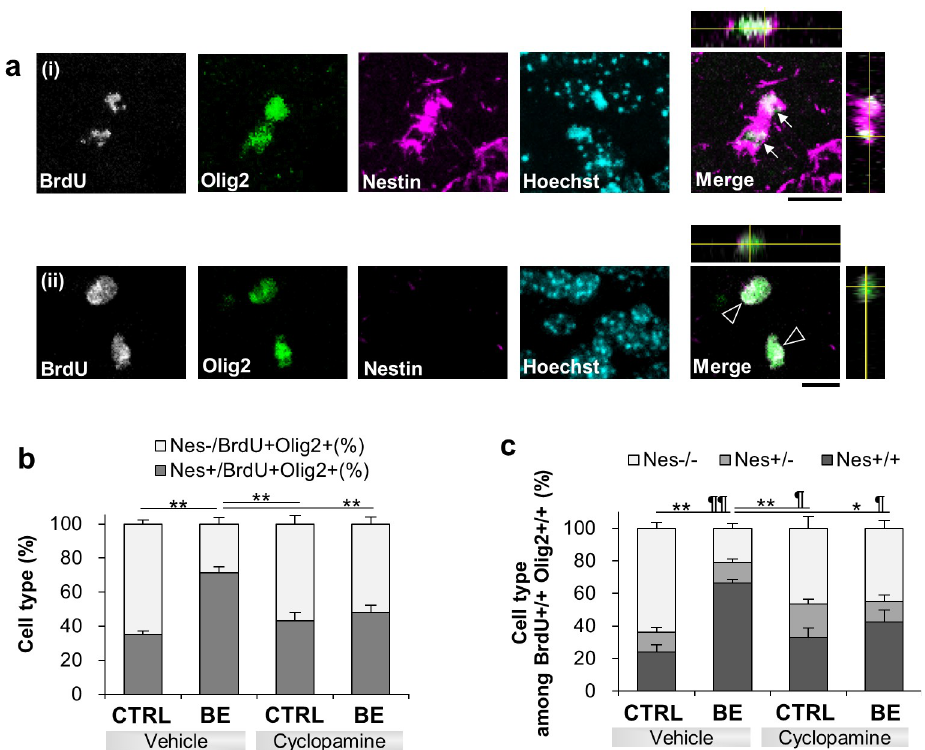
Fig 5. The role of sonic hedgehog signaling in BE-induced undifferentiation at P25. ( a ) Confocal images showing immunostaining against BrdU (gray), Olig2 (green), Nestin (Nes, magenta) along with Hoechst for vehicle-injected control mice. A merged image of the top row omitted Hoechst for clarity. The x-z and y-z cross-section views of the merged image are shown at the top and right side of the image, respectively. White arrows (a i ) and open arrowheads (a ii ) indicate BrdU+Olig2+Nestin+ and BrdU+Olig2+Nestin- cells, respectively. Scale bar, 50 μ m. ( b , c ) Percentages of Nestin labeling among BrdU+Olig2+ singlet cells ( b ) and doublet cells ( c ) for the four conditions described above. � p < 0.05; �� p < 0.01 for Nestin+ or Nestin+/+, and ¶p < 0.05; ¶¶p < 0.01 for Nestin-/-, two-way ANOVA and Tukey-Kramer post hoc test, N = 5 per condition.